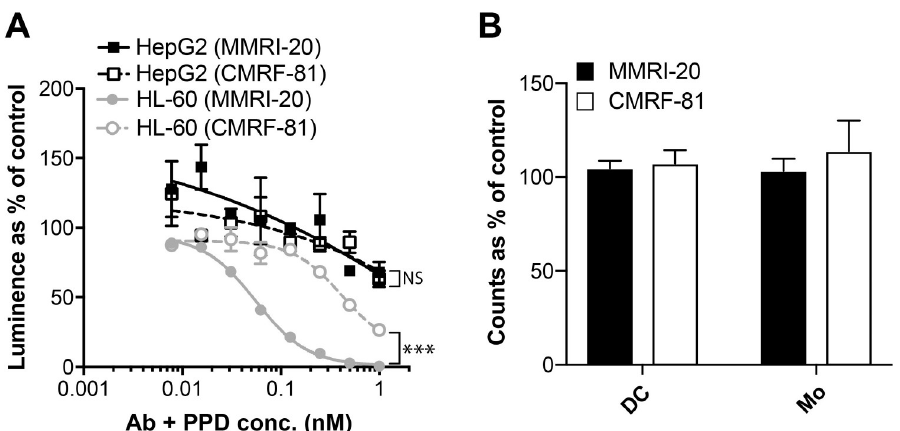
Fig 5. PBD delivery through CD302 mAb mediates killing of leukemic but not hepatic cell lines. (A) Comparison of HepG2 or HL-60 killing after 96 h culture with the indicated concentrations of MMRI-20 or isotype control mAb together with equimolar concentrations of a GAM IgG secondary antibody conjugated with PBD toxin. Cell viability measured with the CellTiter-Glo luminescent assay and compared as a % to untreated controls. One of three representative experiments shown. ��� p < 0.001, 2-way ANOVA. (B) PBMC were cultured in quadruplicate for 96h with 1nM MMRI-20 or isotype control mAb together with equimolar concentrations of a GAM IgG secondary antibody conjugated with PBD toxin. Flow cytometry was used to count viable (DAPI - ) dendritic cells (Lin - HLA-DR + CD11c + ) and monocyte (SSC hi Lineage + HLA-DR + CD11c + ) in wells after culture and compared as a % to untreated controls. One of two representative experiments